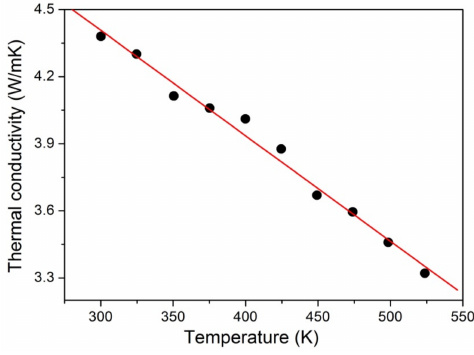
Figure 4. Thermal conductivity versus temperature curve of